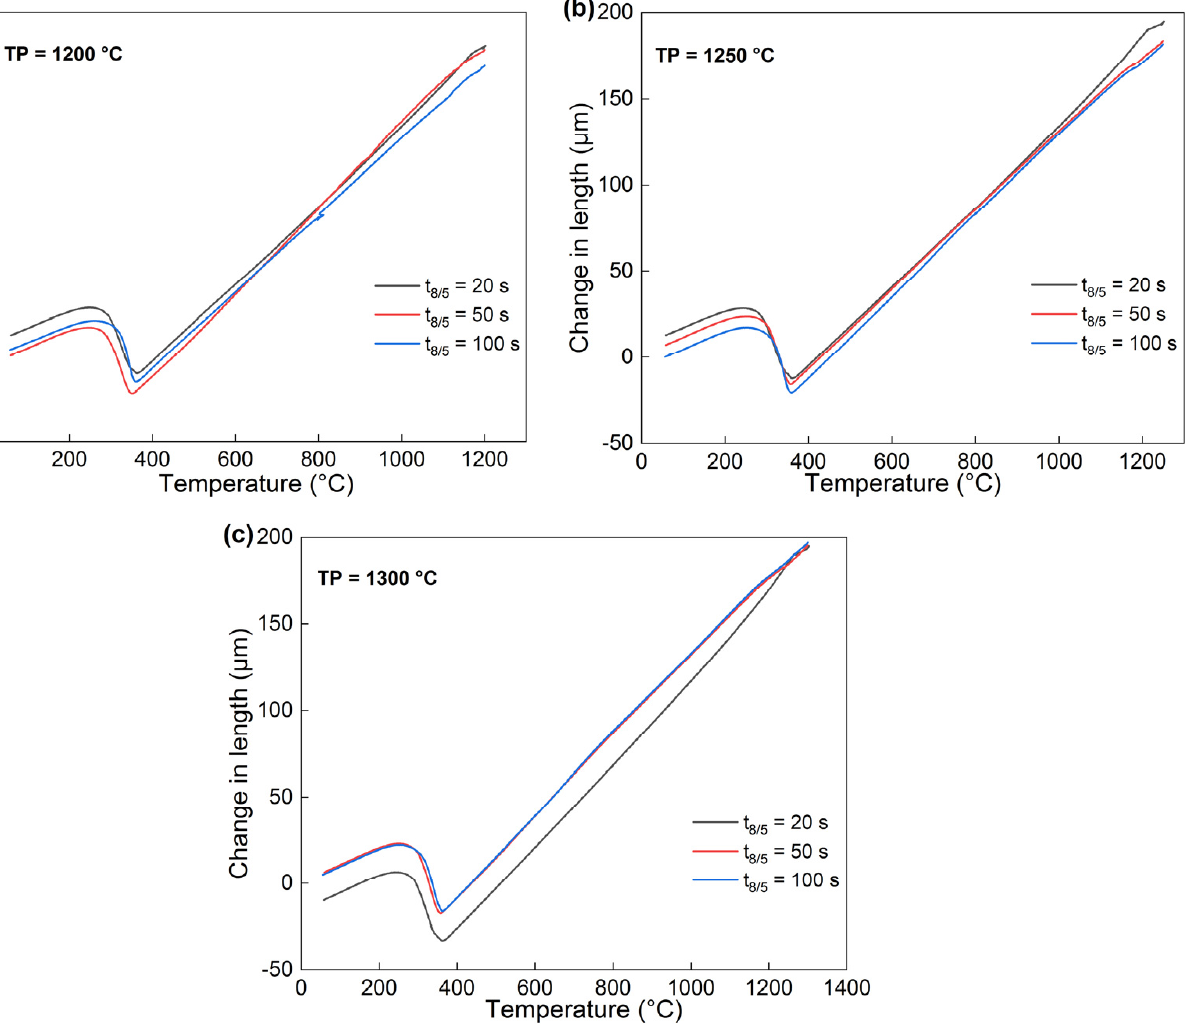
Figure 9. Cooling expansion curves at different peak temperatures and t 8/5 time. ( a ) TP = 1200 °C expansion curve, ( b ) TP = 1250 °C expansion curve, ( c ) TP = 1200 °C expansion curve.